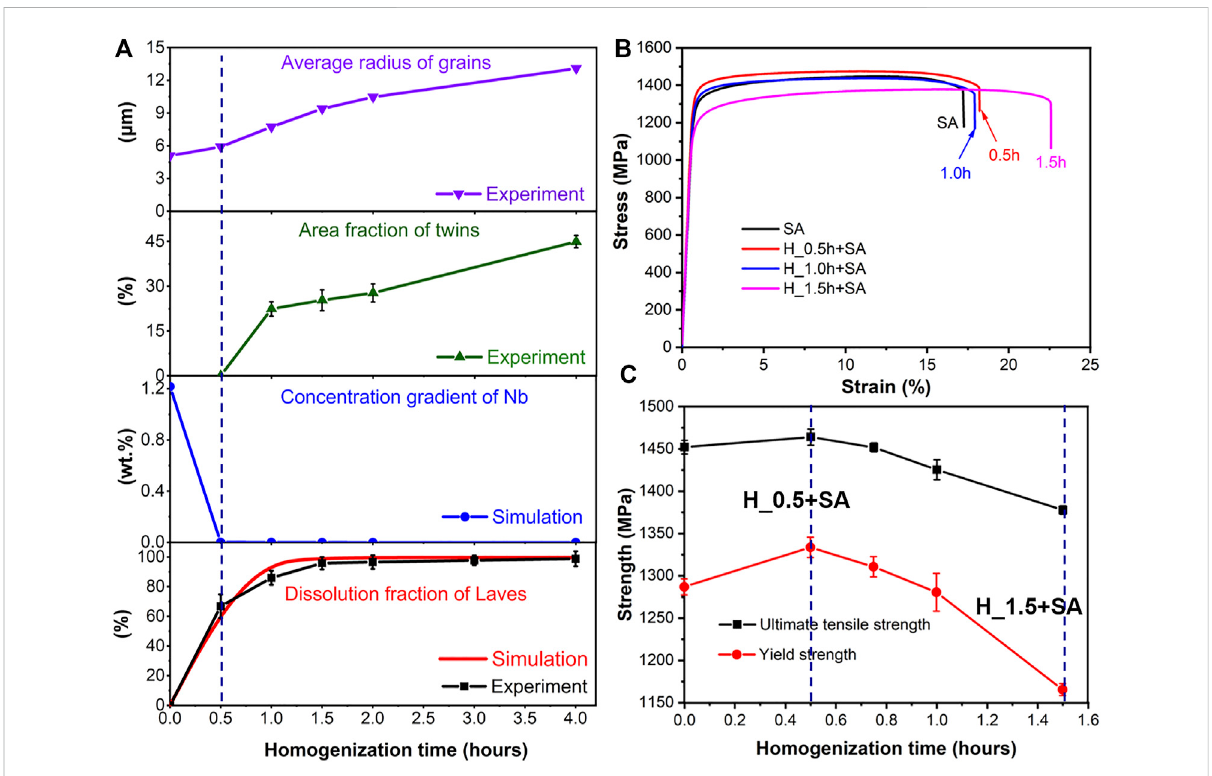
FIGURE 8 (A) Average grain size, area fraction of twins, simulated concentration gradient of Nb, and area fraction of laves phase at homogenization temperature of 1,080 ° C for different times, (B,C) ultimate tensile strength and yield strength of HSA heated Inconel 718 samples at different homogenization